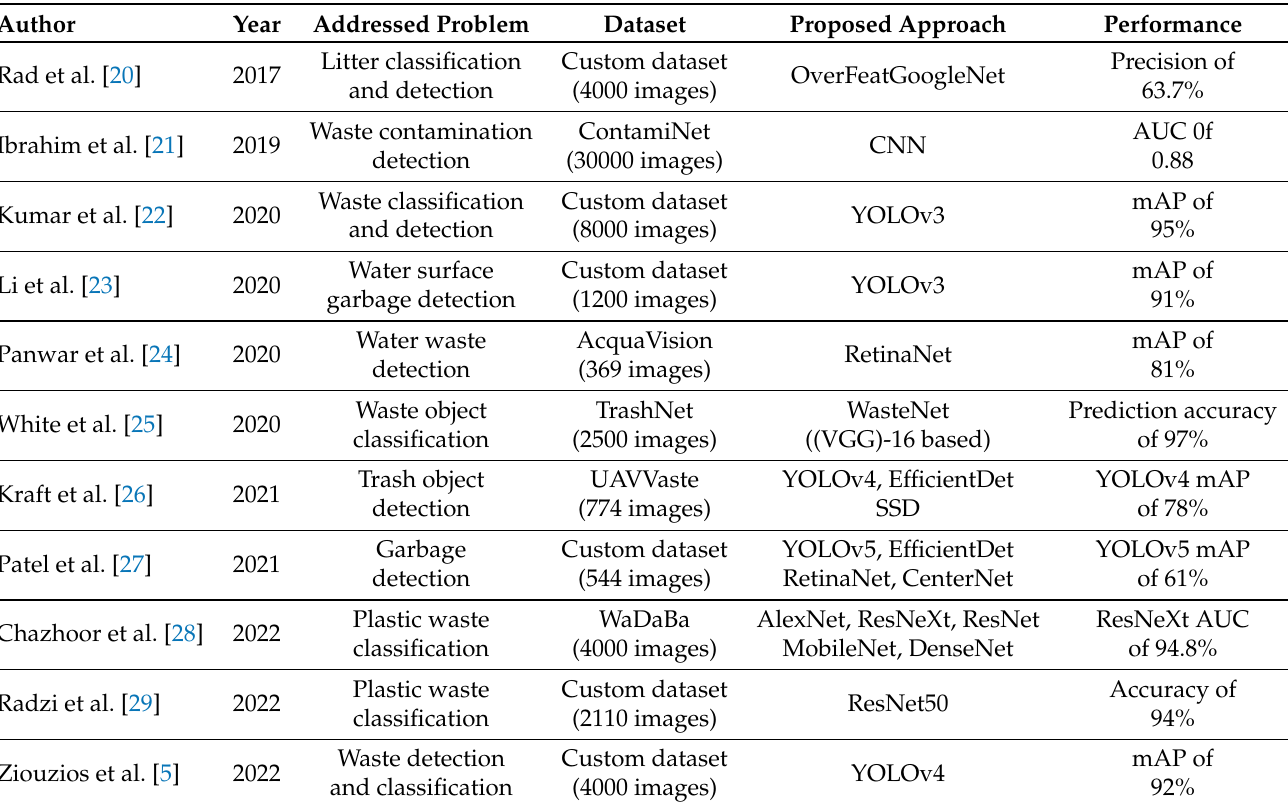
Table 1. Summary of benchmark literature related to detection and classification of waste objects using computer vision